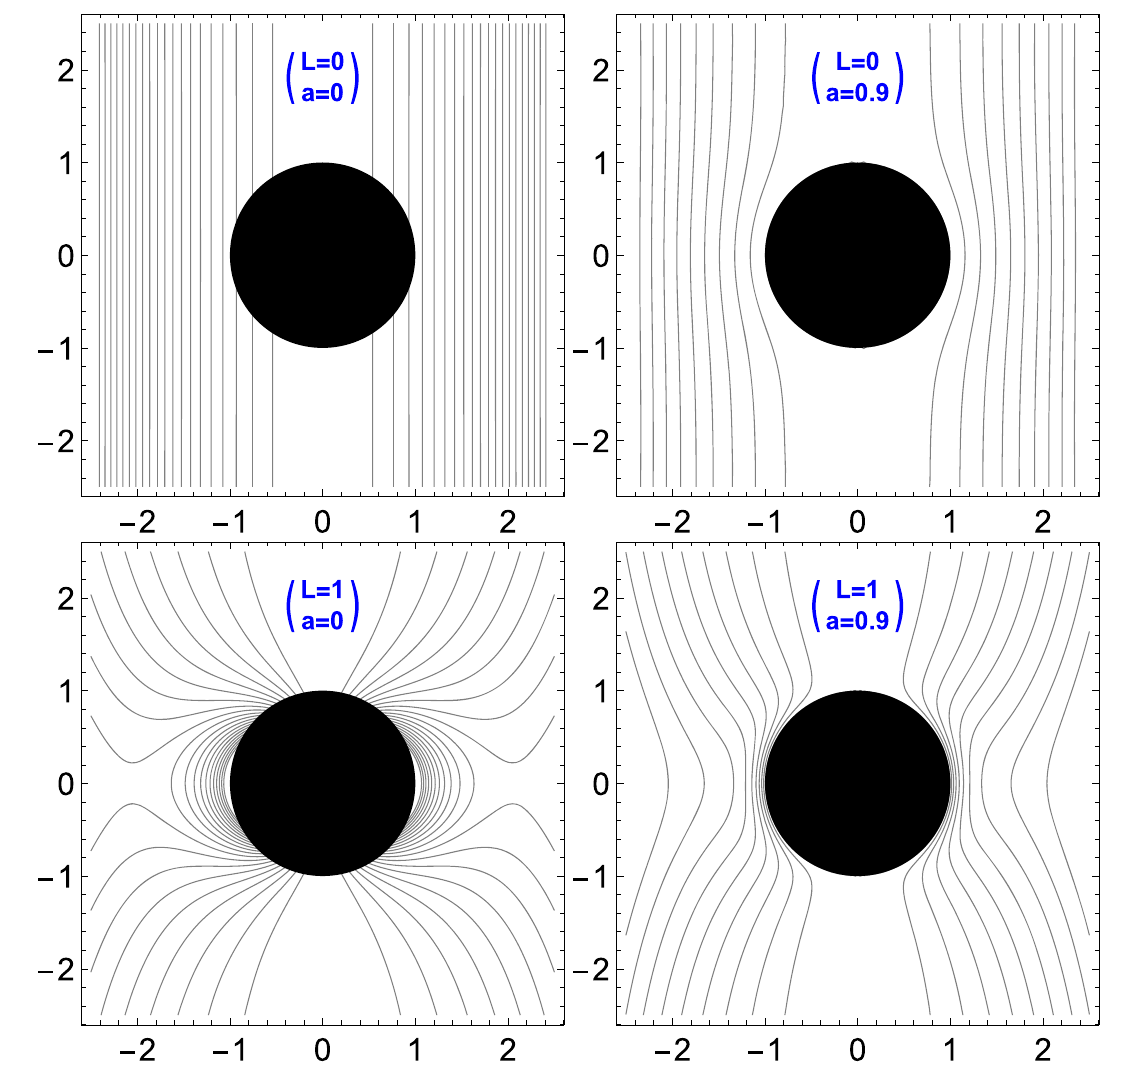
Fig. 3 Magnetic field line profiles around a black hole in the x − z plane for different values of spin parameter a and conformal parameter L . Units in which M =